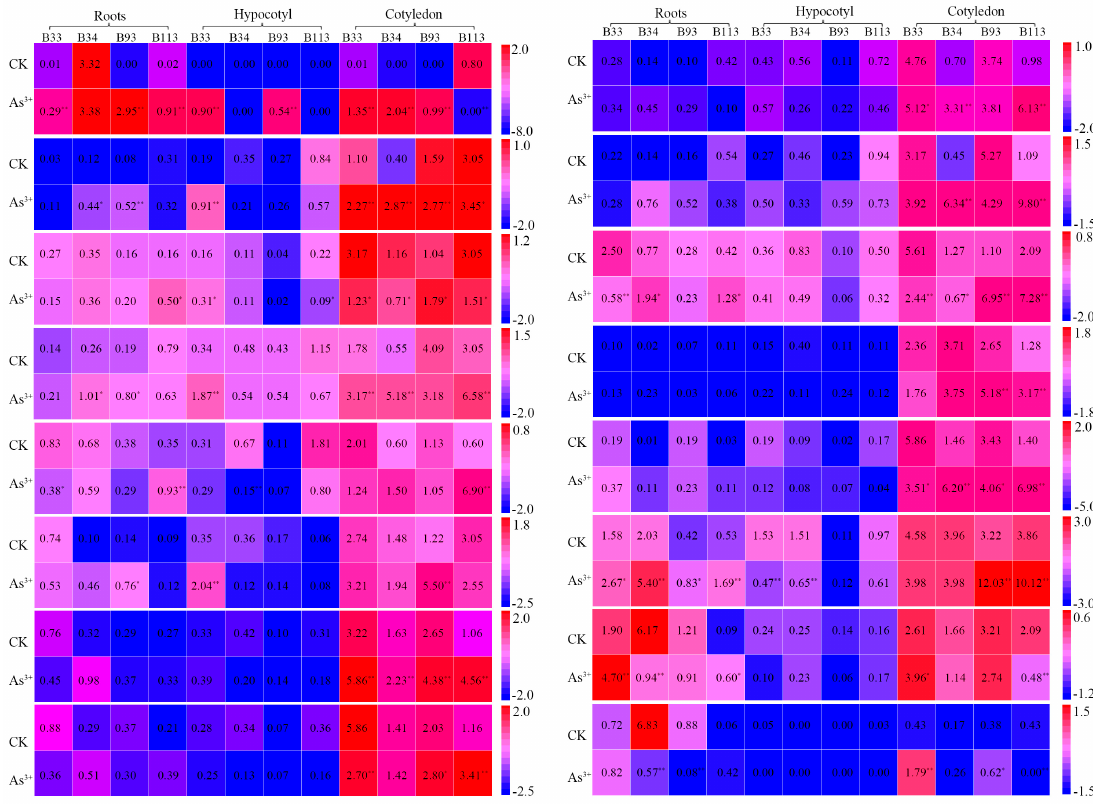
Figure 7. Expression analysis of BnaMT family genes in different tissues under control and As 3+ treatment via real-time RT-PCR (RT-qPCR). Three biological replicates per sample were used for analysis, and three technical replicates were analyzed per biological replicate. Values represent the average of three biological replicates with three technical replicates of each tissue (Table S3). The expression data was gained from the real-time RT-PCR (RT-qPCR) analysis data and shown as log2 as calculated by average values normalized to that of the reference gene BnACTIN7 (EV116054). *, ** indicates a significance level at 0.05 and 0.01, respectively. The heatmap was generated using Heatmap Illustrator v1.0 (HemI v1.0, Huazhong University, Wuhan, China; http://hemi.biocuckoo.org/contact.php).